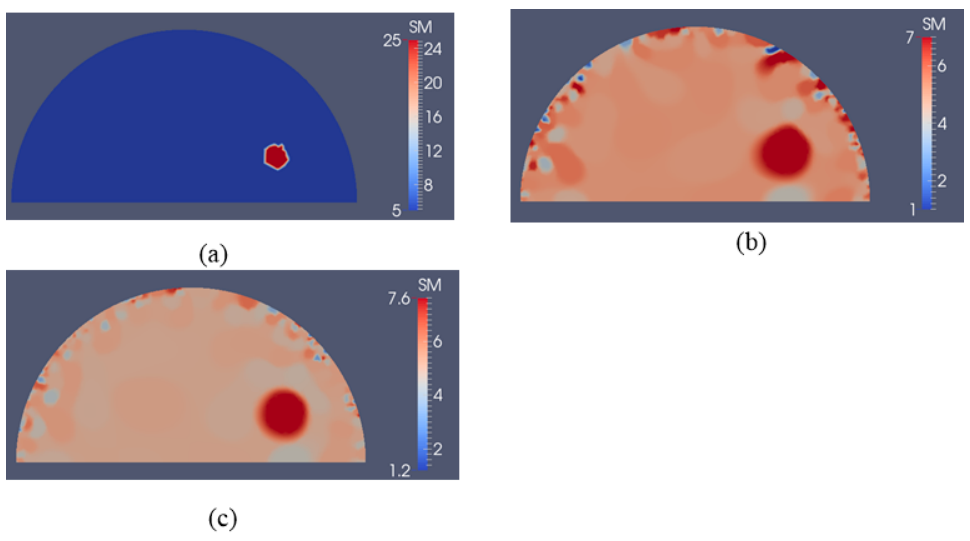
Figure 11. Shear modulus reconstruction with 1% noise. ( a ) target shear modulus distribution with a smaller inclusion radius of 0.5 cm is defined to study detectability of the inclusion to its size; ( b , c ) reconstructed shear modulus distribution using 5 and 10 boundary displacement data sets, respectively (unit in the scale bar: kPa). Note: “SM” stands for shear modulus.